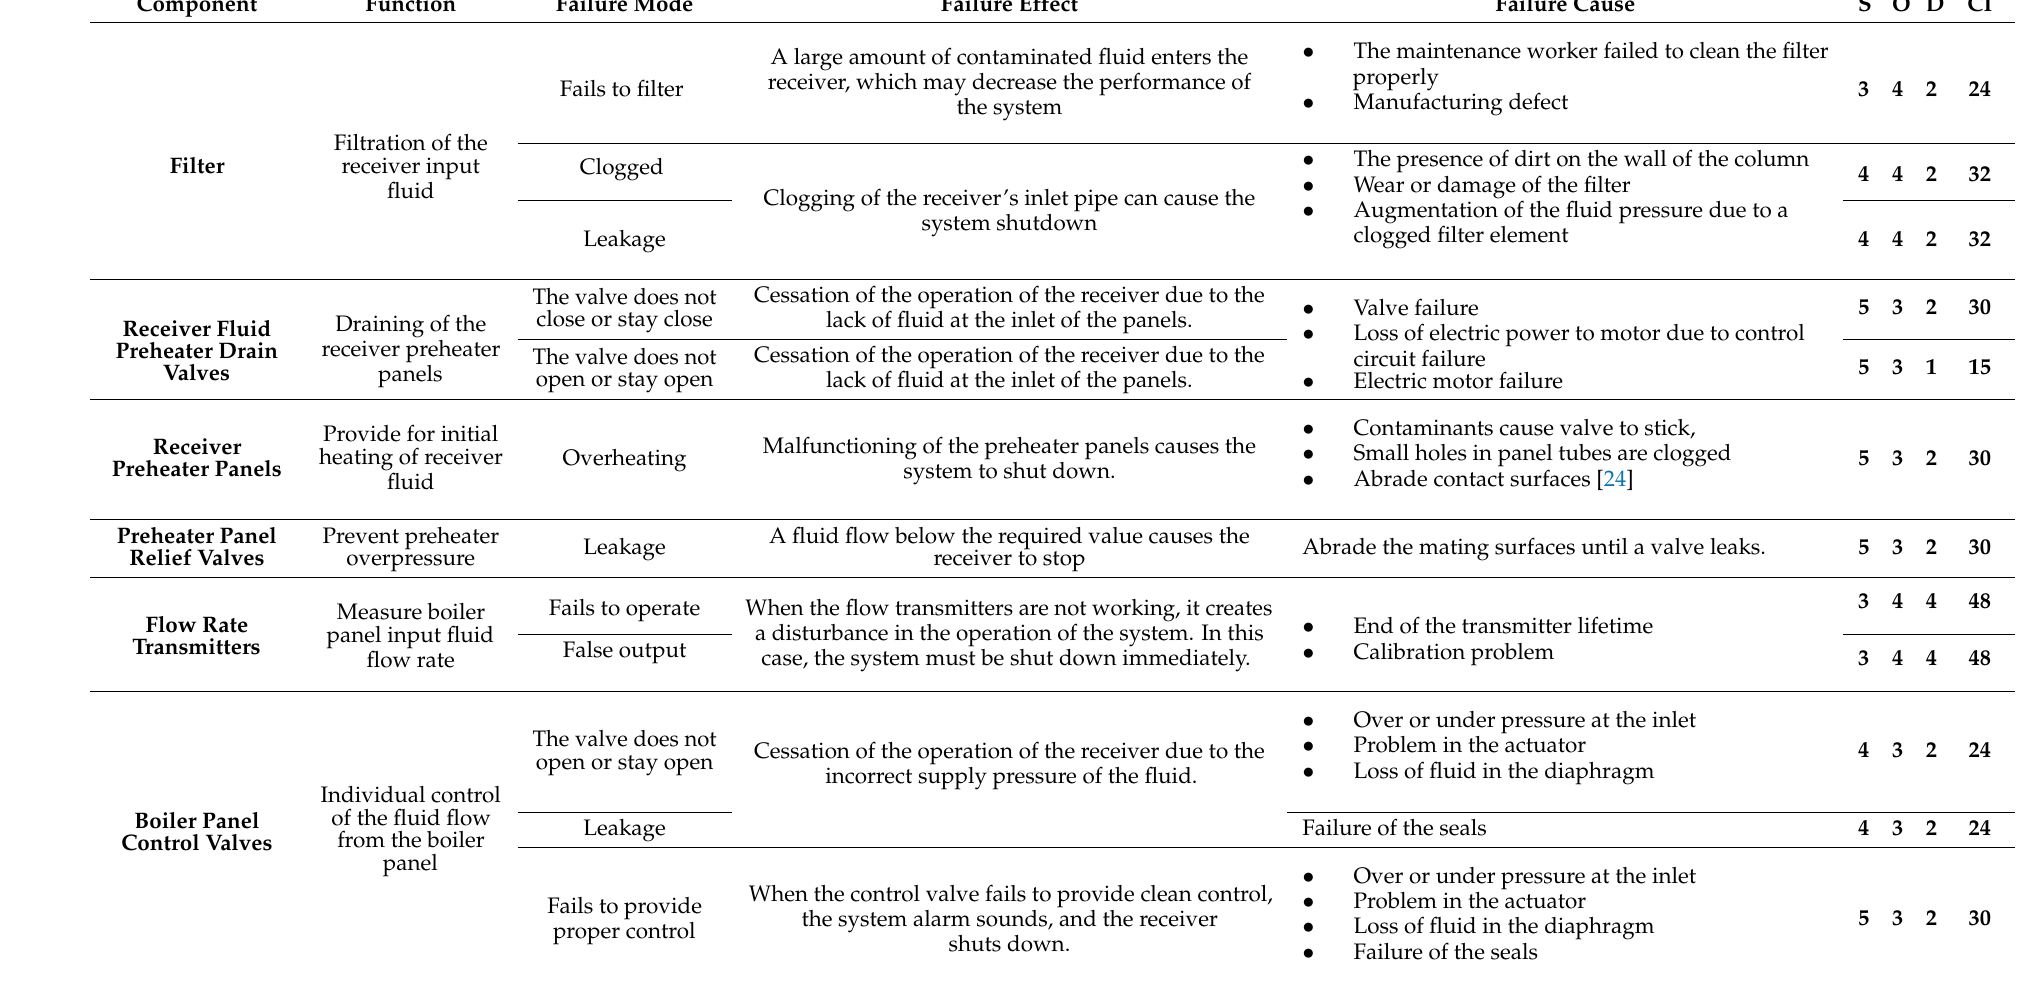
Table 2. Receiver subsystem